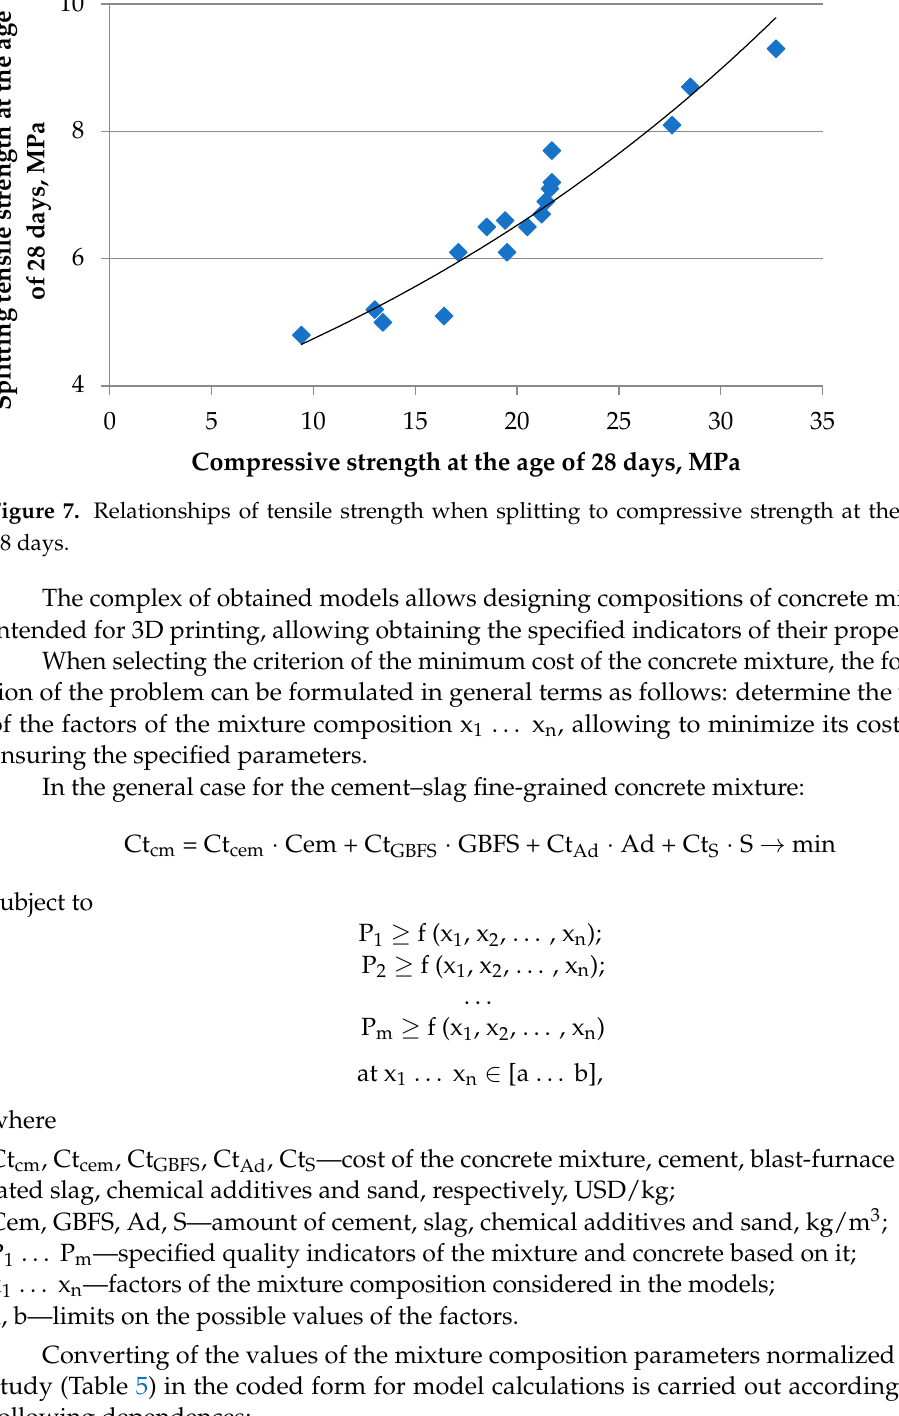
Figure 6. Relationship between setting time and structural strength of concrete.